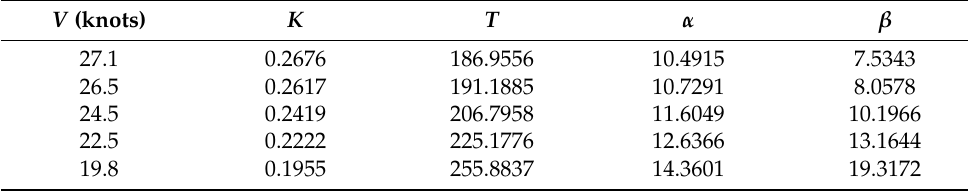
Table 4. Corresponding model parameters under different speeds.